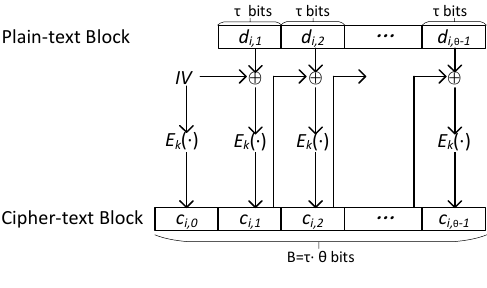
Figure 6. Format of a data